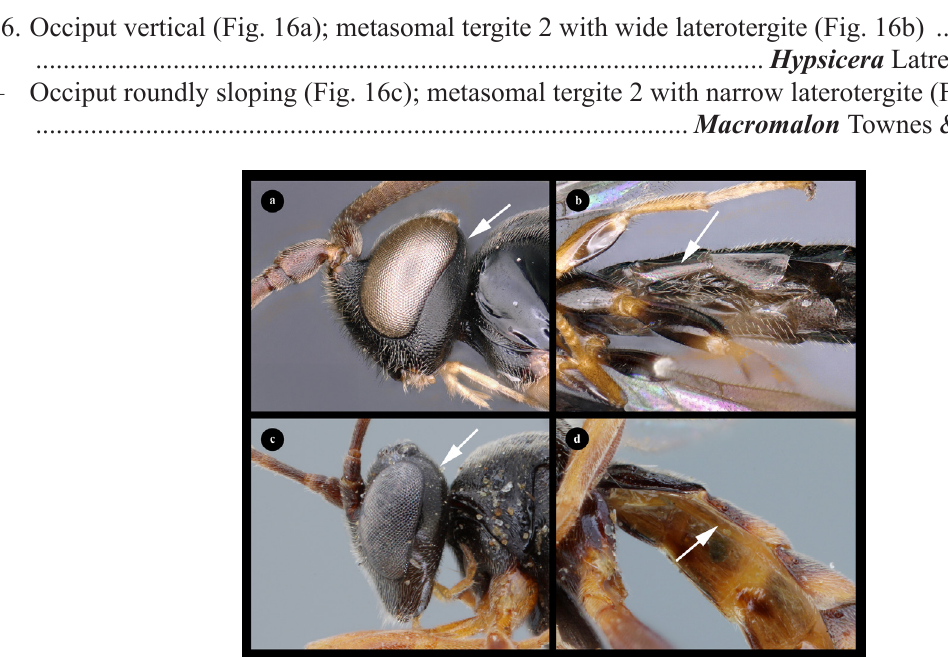
Fig. 16. a–b . Hypsicera sp. a . Head, lateral view. b . Metasoma, ventral view. c–d . Macromalon sp. c . Head, lateral view. d . Metasoma, ventral view. Arrow in Fig. 16a points to vertical occiput (compared to rounded occiput in Fig. 16c). Arrow in Fig. 16b points to wide laterotergite on metasomal tergite 2 (compared to narrow laterotergite on metasomal tergite 2 in Fig.